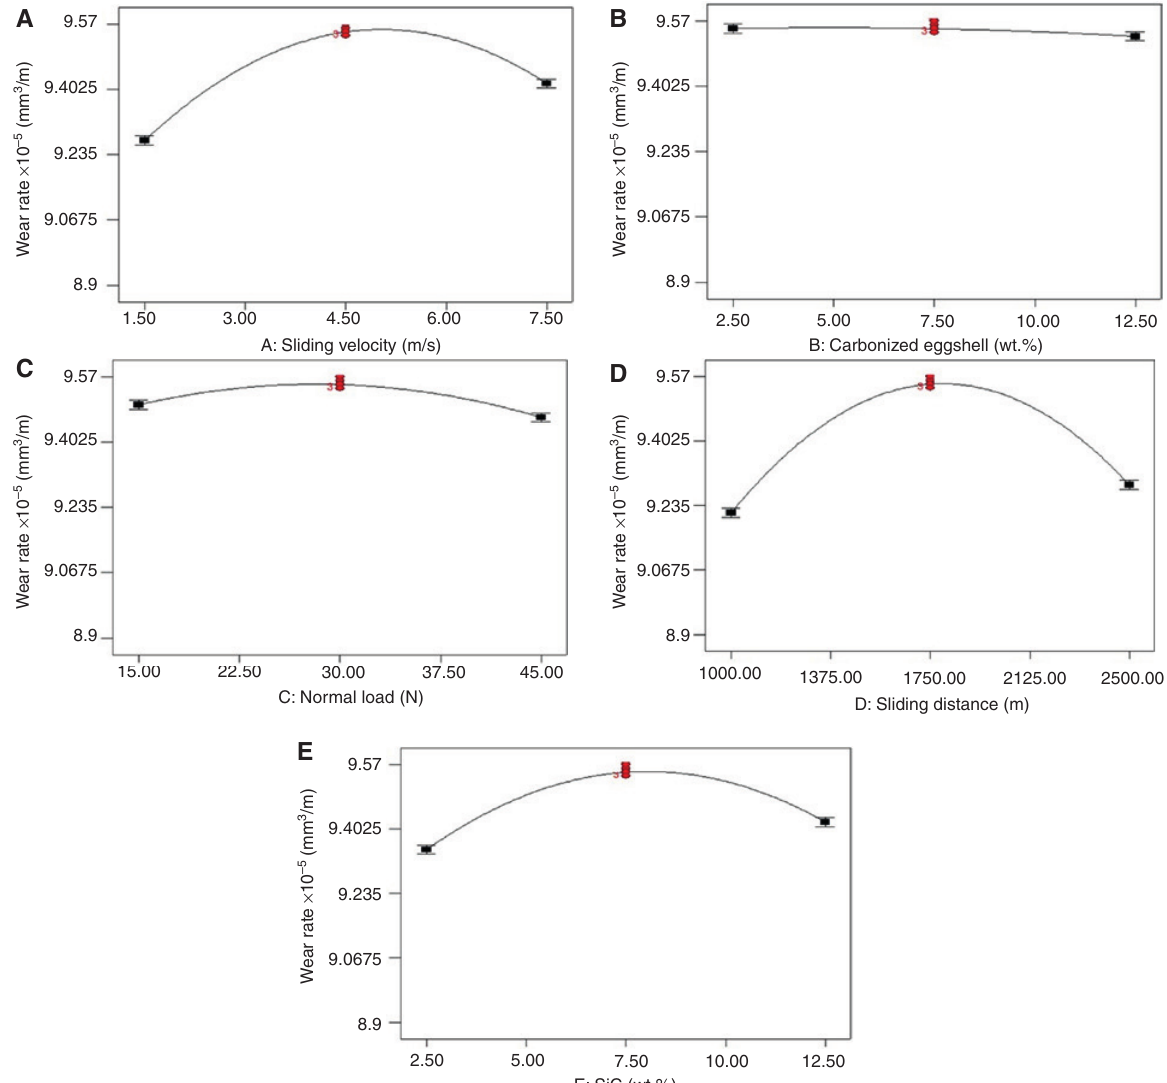
Figure 9: Single factor effects on wear of hybrid